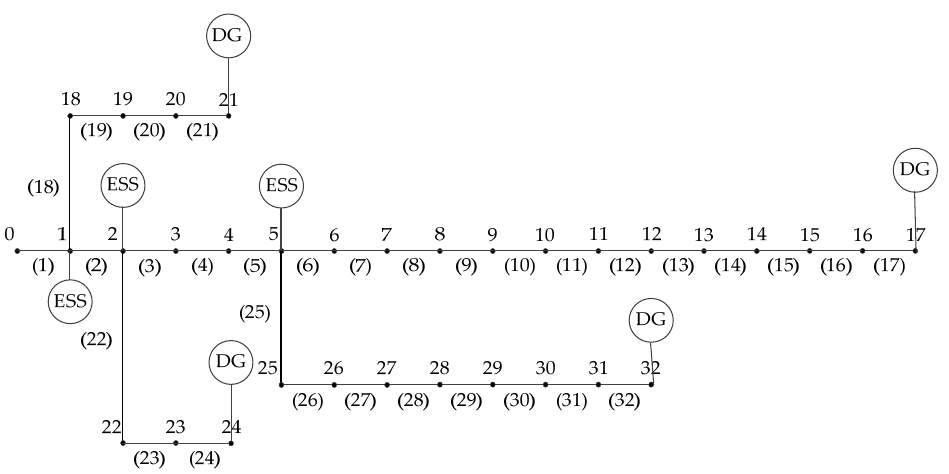
Table 1. Components inside the distribution station area.